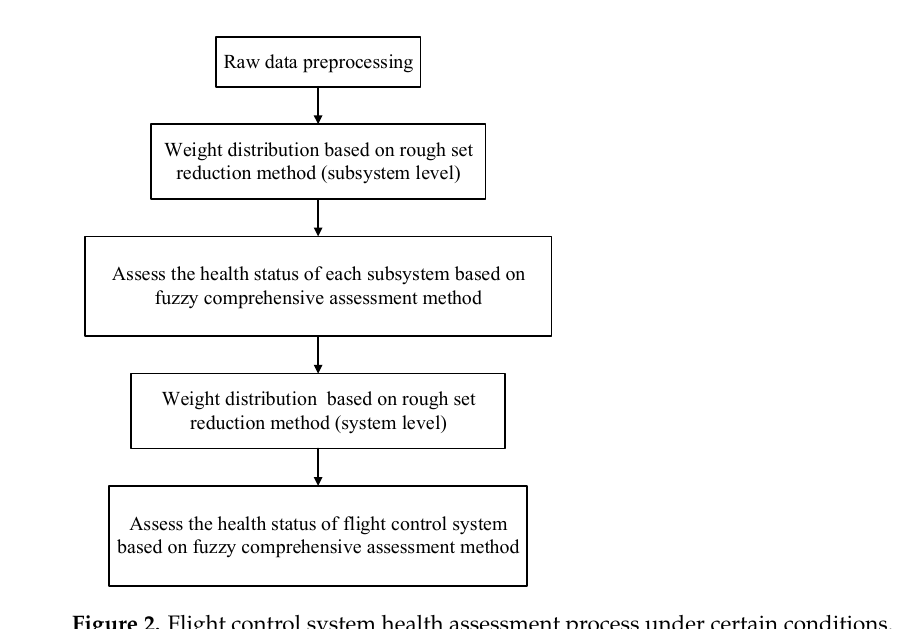
Figure 2. Flight control system health assessment process under certain conditions.